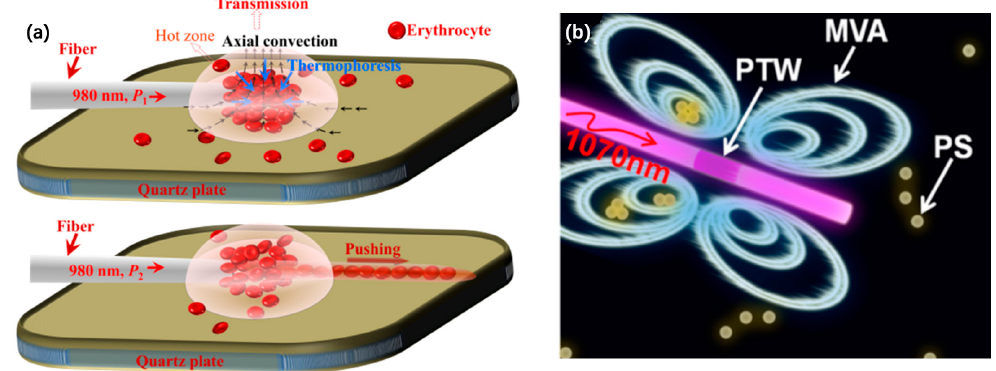
Figure 18. Schematic diagrams of optical trapping and manipulation based on the photothermal